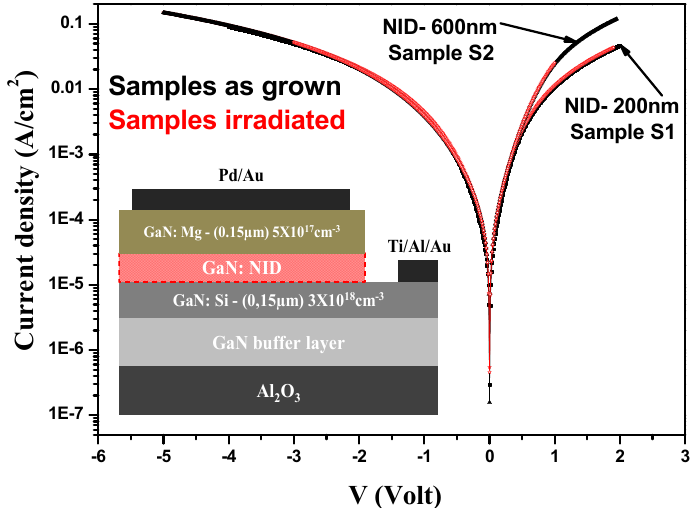
Figure 2. Semi-logarithmic plots of dark current-voltage (I-V) characteristics of both GaN p-i-n junctions (with two different thicknesses of undoped layer respectively at 200 nm and 600 nm) as-grown and irradiated at room temperature with a diameter of diodes of 1000